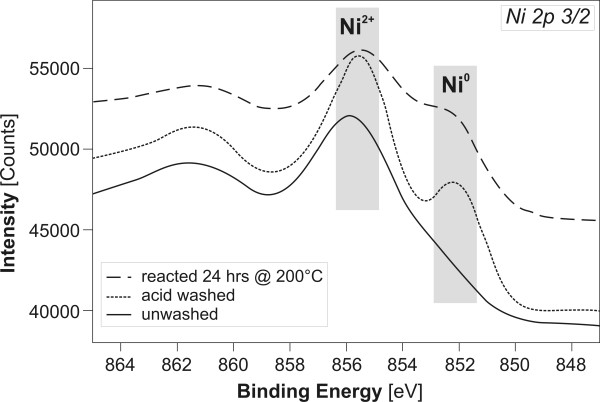
Ni 2p3/2 peaks showing the speciation of Ni on the surface Ni metal powder at various stages of the experiment. Note the presence of residual zerovalent Ni on the surface after 24 hour reaction at 200°C.